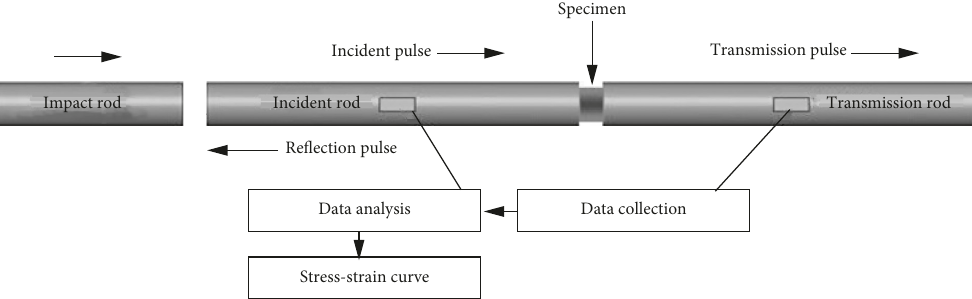
Figure 1: Diagram of the SHPB experimental system. Table 1: Results of the SHPB test on